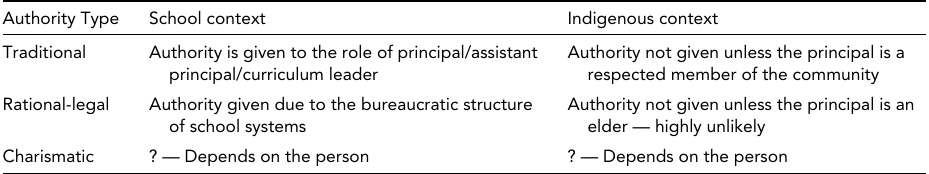
Authority Type Applied to the Leadership Team Within the School and Indigenous Contexts